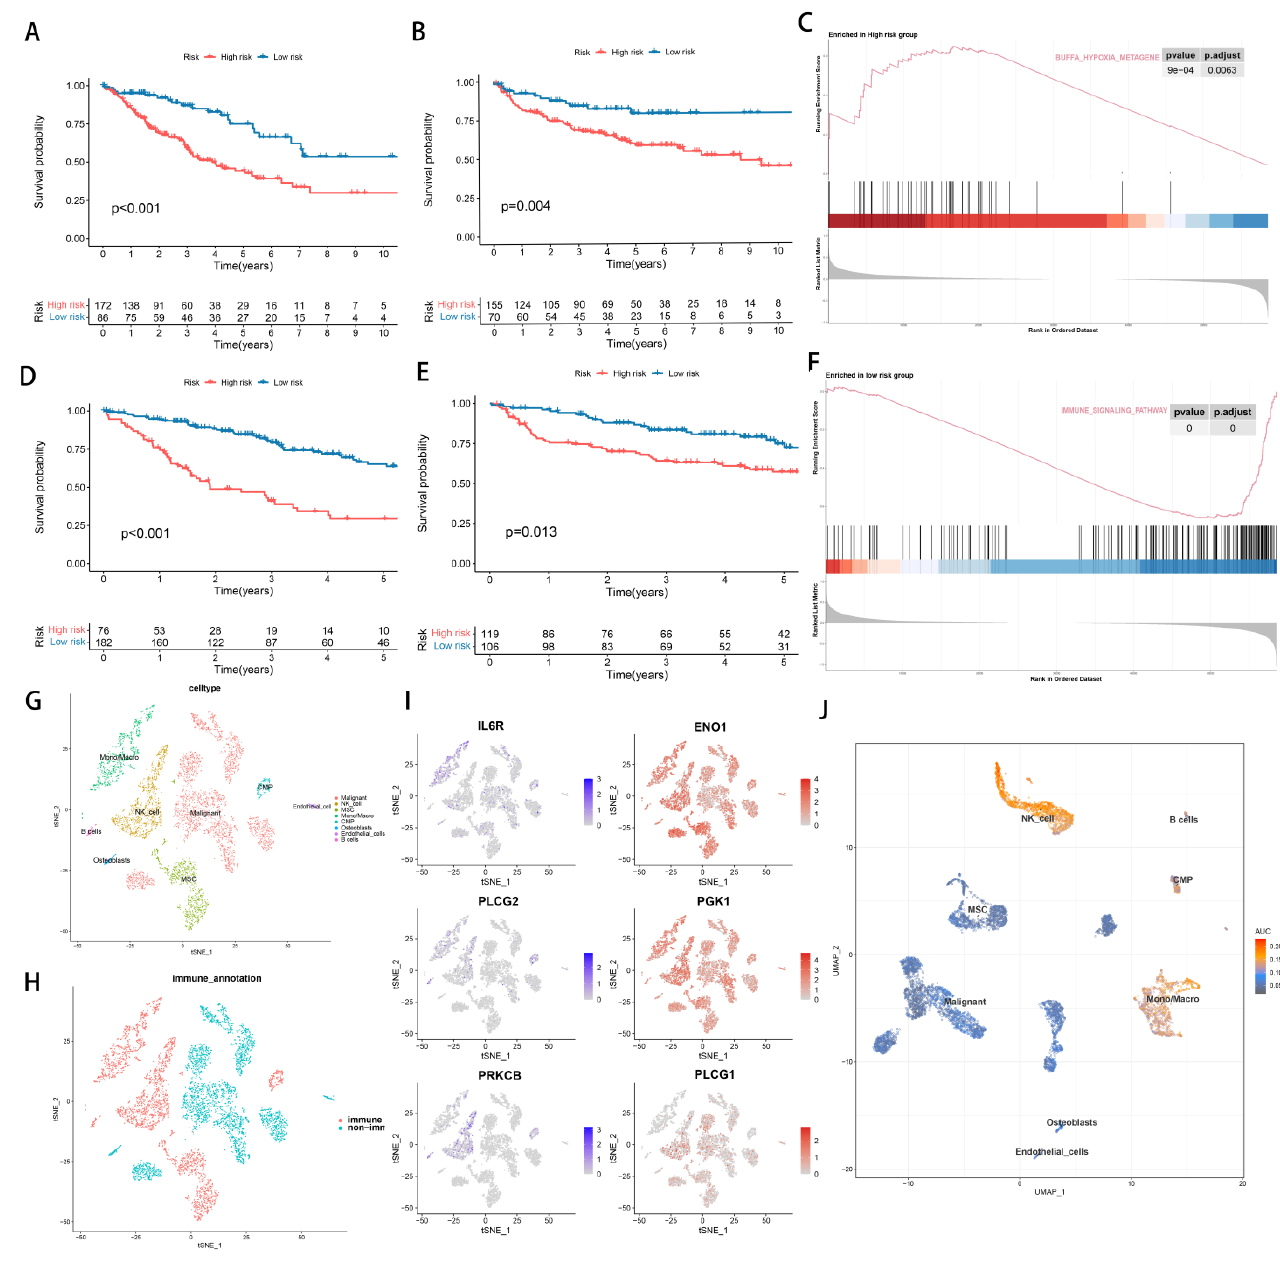
Figure 3. The establishment and identification of hypoxia signatures and TME signatures. ( A ) KM curve of hypoxia − related signature in training cohort. ( B ) KM curve of hypoxia − related signature in testing cohort. ( C ) GSEA enrichment map of DEGs in hypoxia − related subgroups. ( D ) KM curve of TME − related signature in training cohort. ( E ) KM curve of TME − related signature in testing cohort. ( F ) GSEA enrichment map of DEGs in TME-related subgroups. ( G – J ) Single cell analysis of GSM3770931 data.